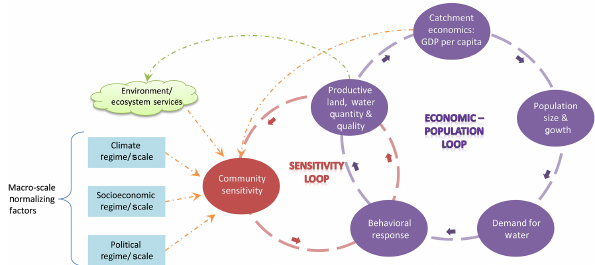
Figure 2. ©Elshafei et al. (2014), reproduced with permission under the CC Attribution License 3.0. A conceptual representation of a socio-hydrological system (Elshafei et al.,